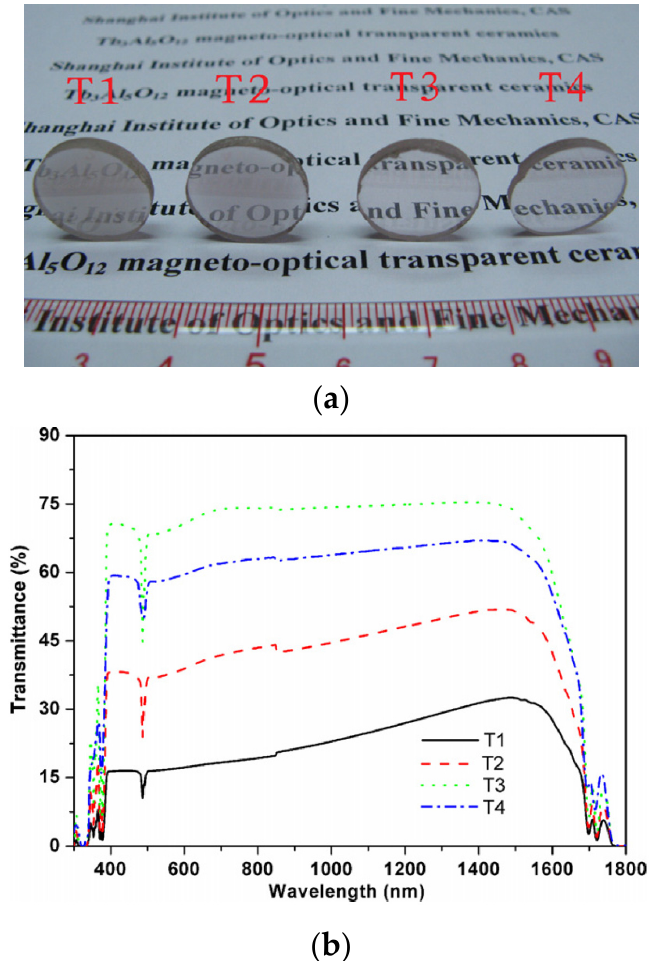
Figure 8. Optical quality of TAG transparent nano-ceramics; ( a ) samples and ( b ) optical transmittance of polished TAG transparent nano-ceramics [49]. Reprinted with permission from Ref. [49]. Copyright 2011, copyright ELSEVIER.